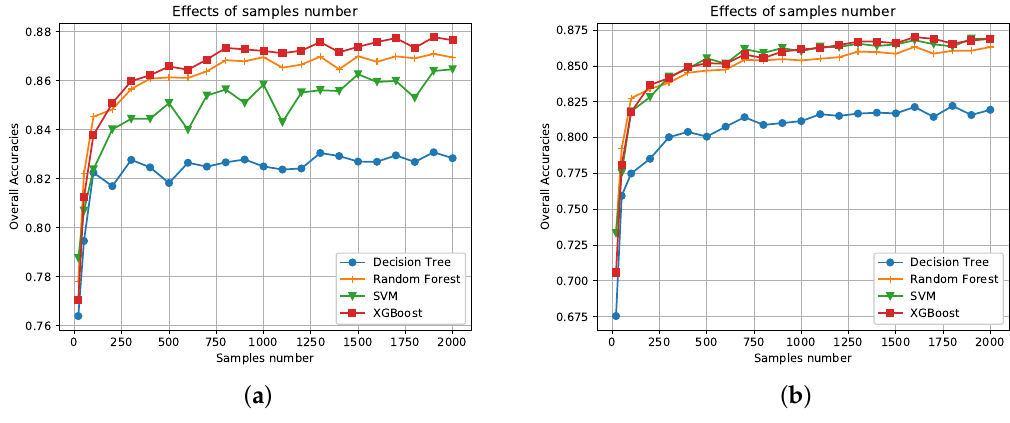
Figure 10. Effects of the training sample size. ( a ) Data set A. ( b ) Data set